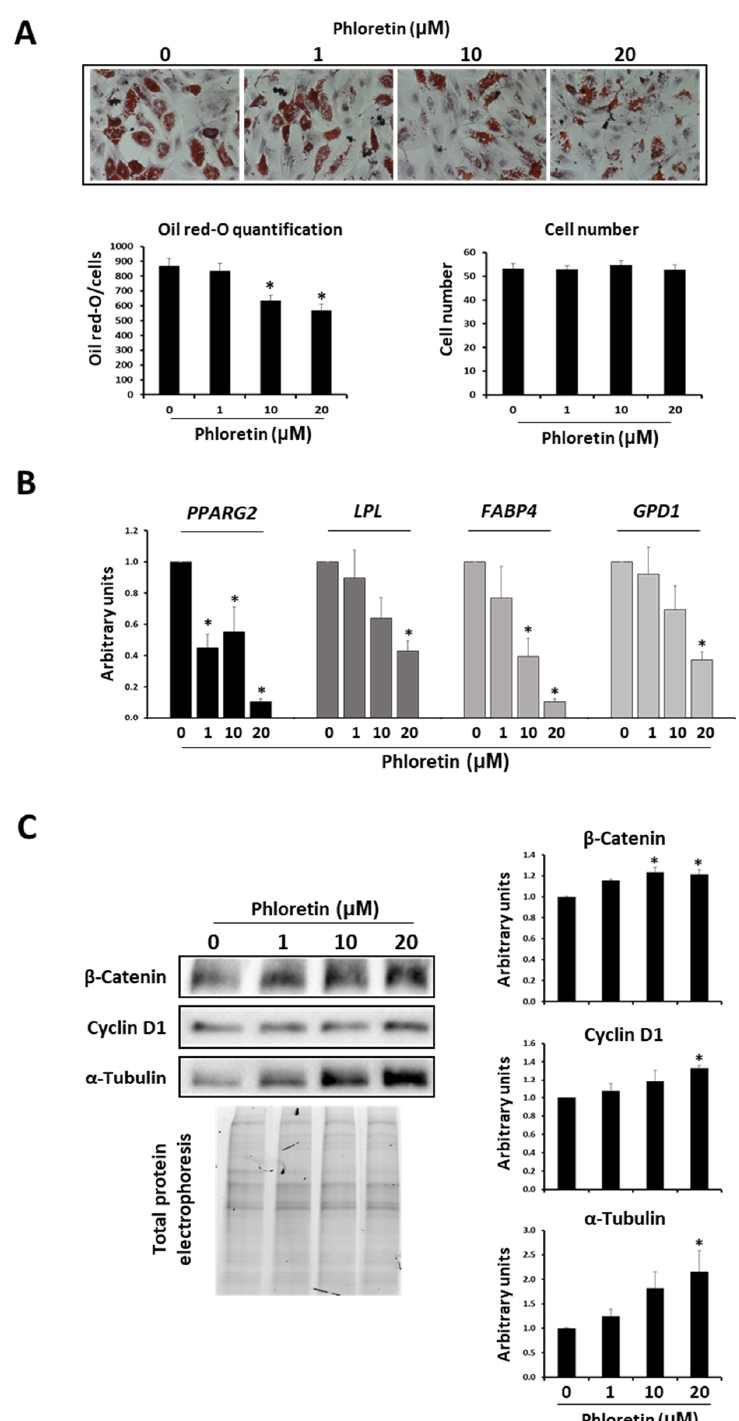
Figure 7. Effects of phloretin on adipocytes treated for 5 days from day 13 of the start of differentiation. ( A ) Representative light-microscopy pictures (200X) of oil red-O staining of cultures treated with different phloretin concentrations. Graphs show oil red-O quantification and cell-number estimation by image analyses. ( B ) Gene expression of adipogenic marker genes ( PPARG2 , LPL , FABP4 , and GPD1 ). ( C ) Western blot for β -catenin, cyclin D1, and α -tubulin, in cultures of adipocytes treated with 0, 1, 10, or 20 µM of phloretin at days 13 to 18 of adipogenic differentiation. * p < 0.05 vs. cultures no treated (0 µM of phloretin).